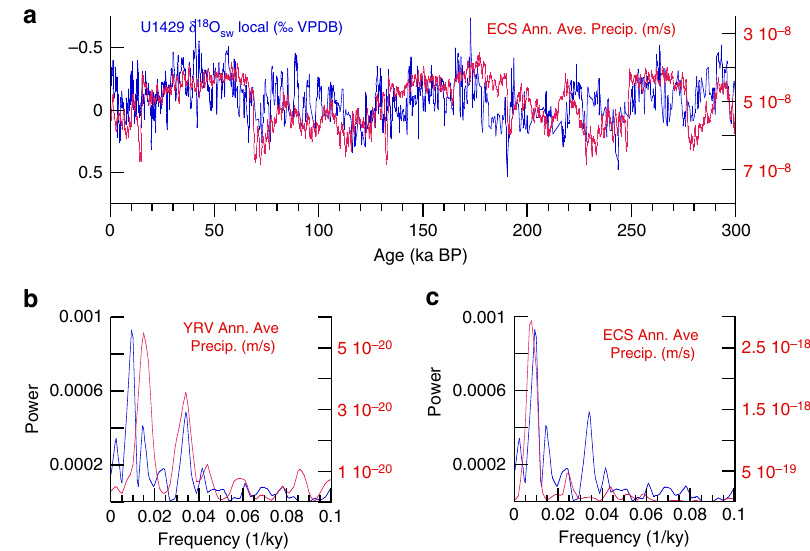
Fig. 6 Comparison of model (annual average, red) and U1429 (blue) time series and spectra. a U1429 local δ 18 O sw and East China Sea (ECS) model annual average precipitation. The U1429 record is consistent with b annual average precipitation over the Yangtze River Valley (YRV) accounting for the 29- and 69-ky variance and c ECS annual average precipitation, accounting for the 100- and 41-ky variance. Supplementary Figure 6 shows comparisons of δ 18 O cave (for which temperature has not been removed) with model temperature and precipitation (monthly annual, maximum, and